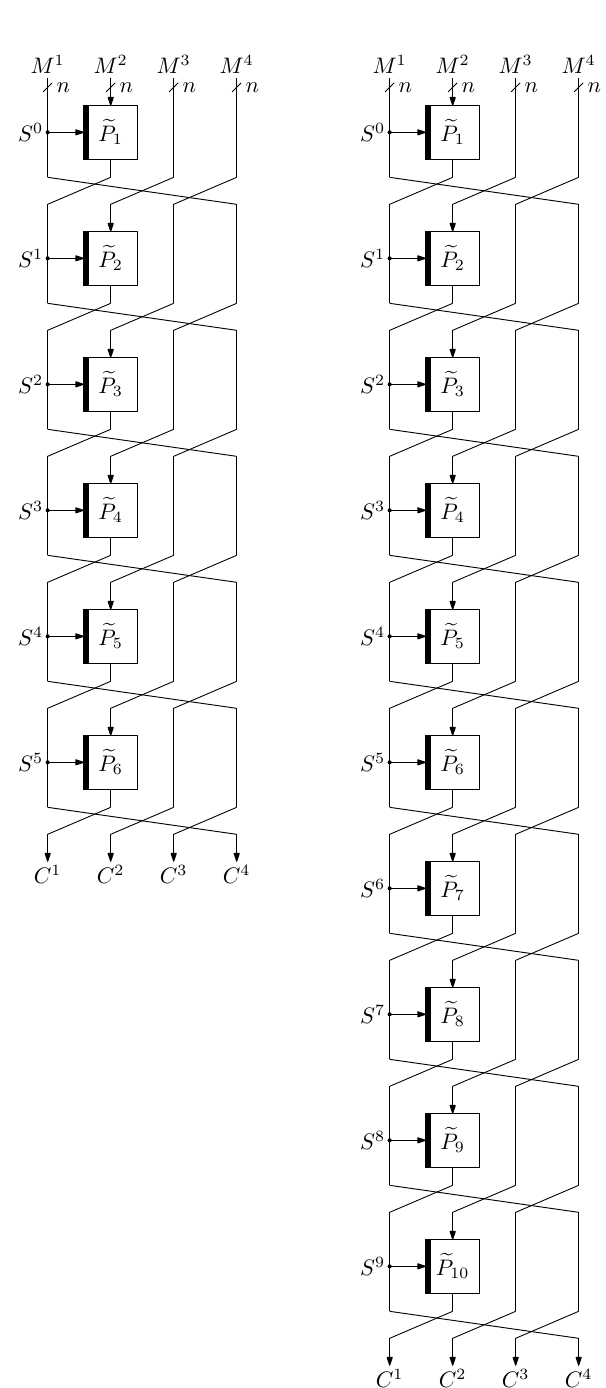
Figure 7: Left: E 1 ,d,r ( M 1 ∥ · · · ∥ M 4 ) = ( C 1 ∥ · · · ∥ C 4 ) for the case d = 4 and r = 6, where ( M 1 ∥ · · · ∥ M 4 ) = ( S 0 ∥ S − 3 ∥ S − 2 ∥ S − 1 ) and ( C 1 ∥ · · · ∥ C 4 ) = ( S 6 ∥ S 3 ∥ S 4 ∥ S 5 ). Right: E ( M 1 ∥ · · · ∥ M 4 ) = ( C 1 ∥ · · · ∥ C 4 ) for the case d = 4 and r = 10, where 1 ,d,r ( M 1 ∥ · · · ∥ M 4 ) = ( S 0 ∥ S − 3 ∥ S − 2 ∥ S − 1 ) and ( C 1 ∥ · · · ∥ C 4 ) = ( S 10 ∥ S 7 ∥ S 8 ∥ S 9